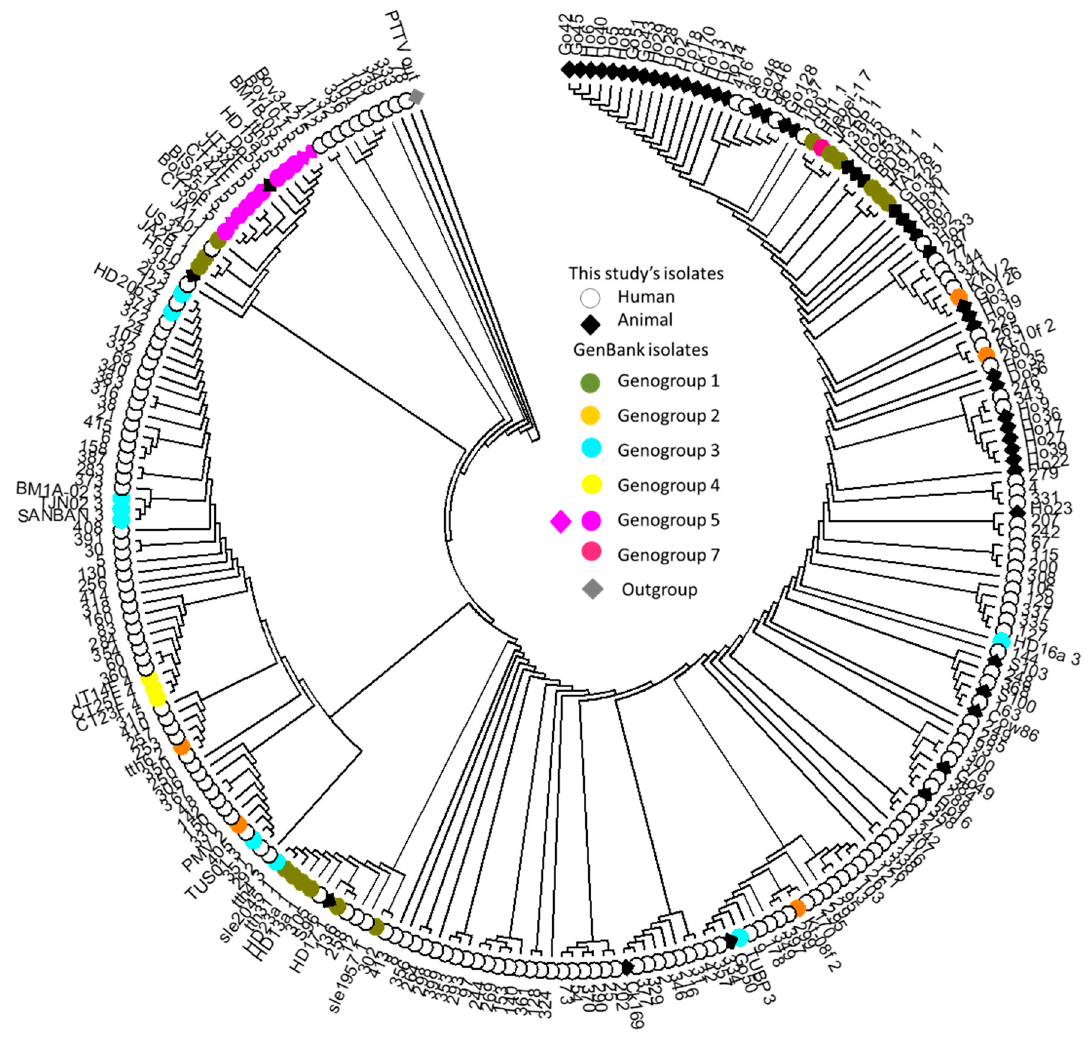
Figure 3. Phylogenetic tree constructed by the neighbor-joining method based on the 5 ′ -UTR for human and animal TTV isolates. The evolutionary history was inferred using the Neighbor-Joining method and rooted using the pigeon Torque teno virus (PTTV) sequence as an outgroup. The evolutionary distances were computed using the Maximum Composite Likelihood method and are in the units of the number of base substitutions per site. The analysis involved 249 nucleotide sequences (50 animals, 154 human and 45 from GenBank representing 6 common genogroups). All ambiguous positions were removed for each sequence pair, leaving a total of 125 positions in the final dataset. Abbreviations: Ho: horse; S: sheep; Go: goat; Ck: chicken; Do: donkey. Human isolates are represented by circles and animal isolates by diamonds.